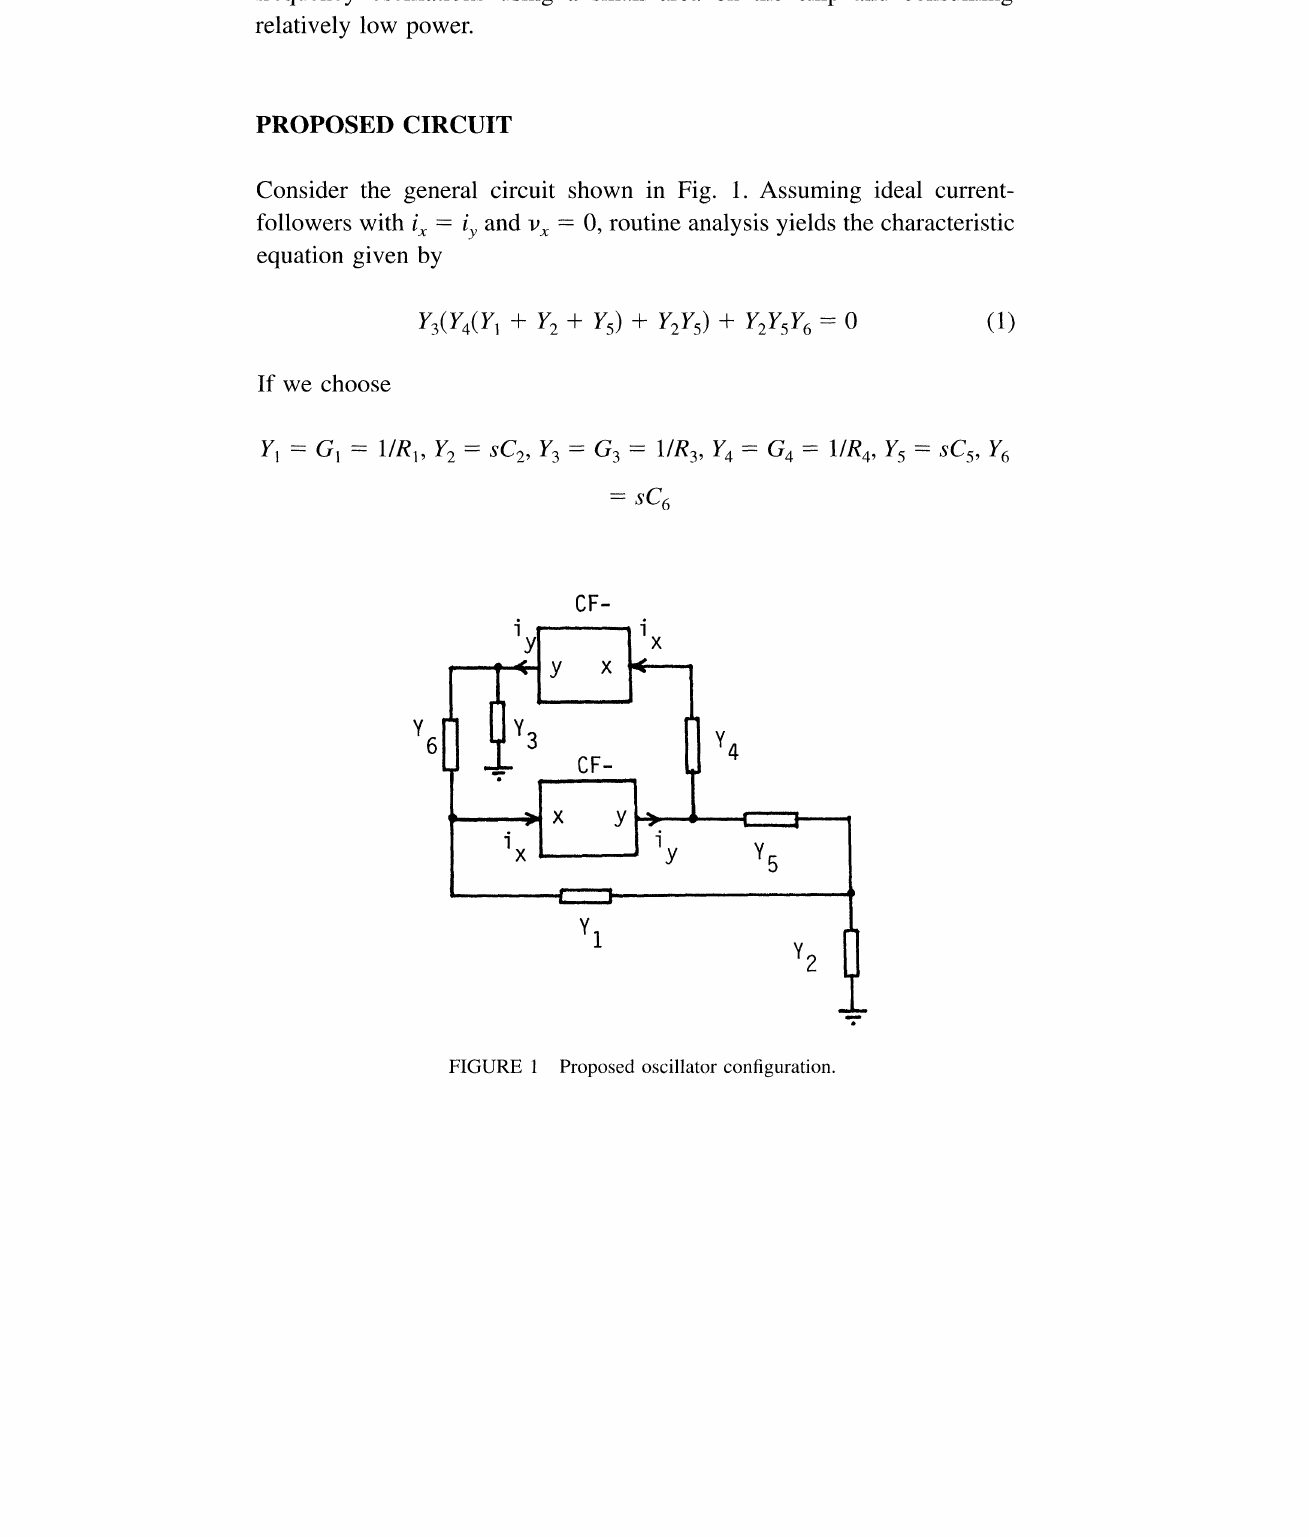
FIGURE Proposed oscillator